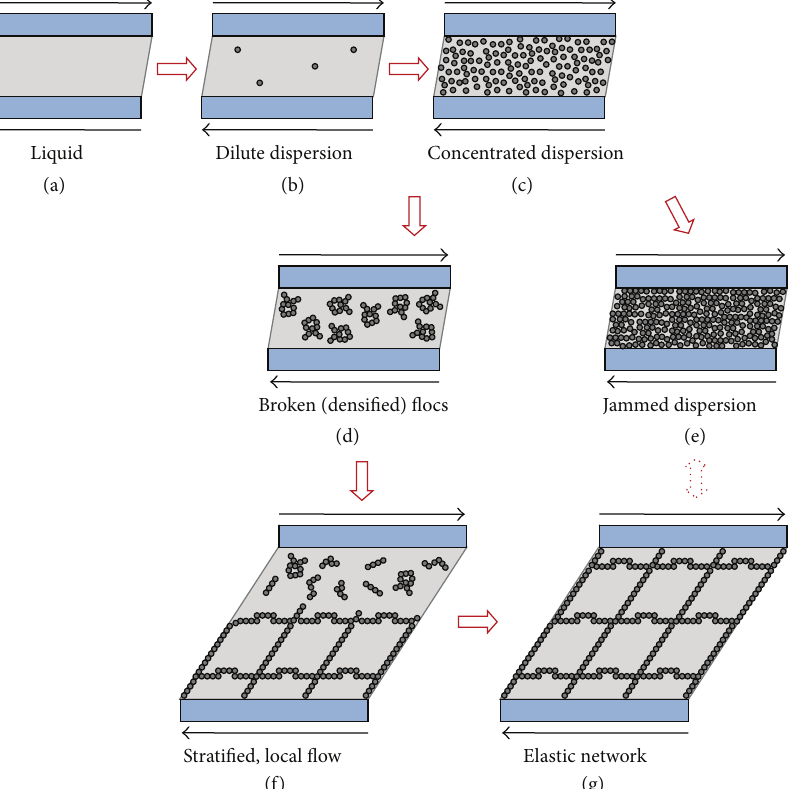
Figure 7: Schematic of different physical flow behaviours of repulsive or granular particles (dispersed) and attractive particles (aggregated) of various concentrations, in response to imposed shear. Arrows indicate increased ordering of